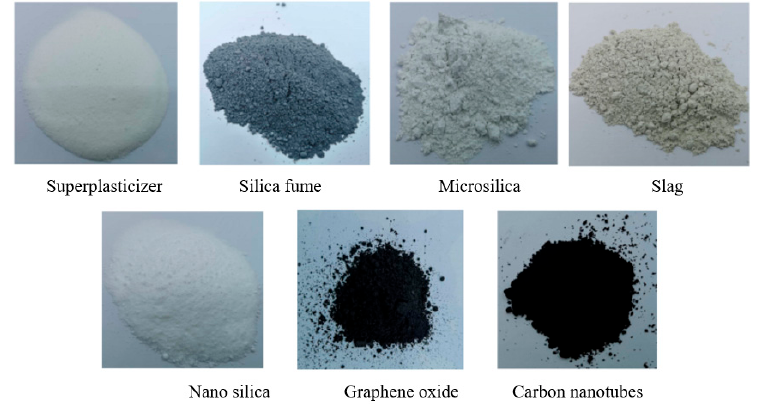
Figure 1. Appearance of the admixtures.